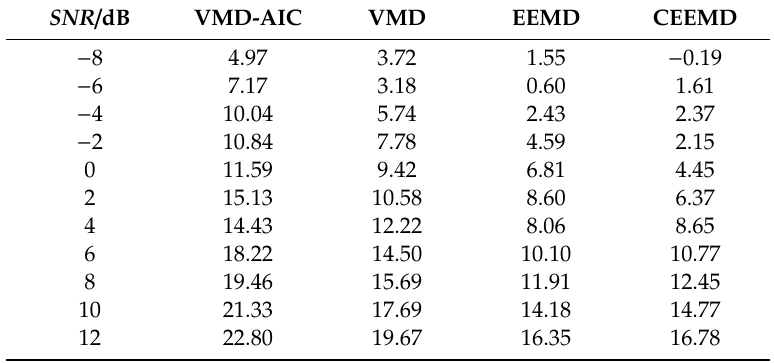
Table 2. Denoising e ff ect of signals with di ff erent SNR s using di ff erent